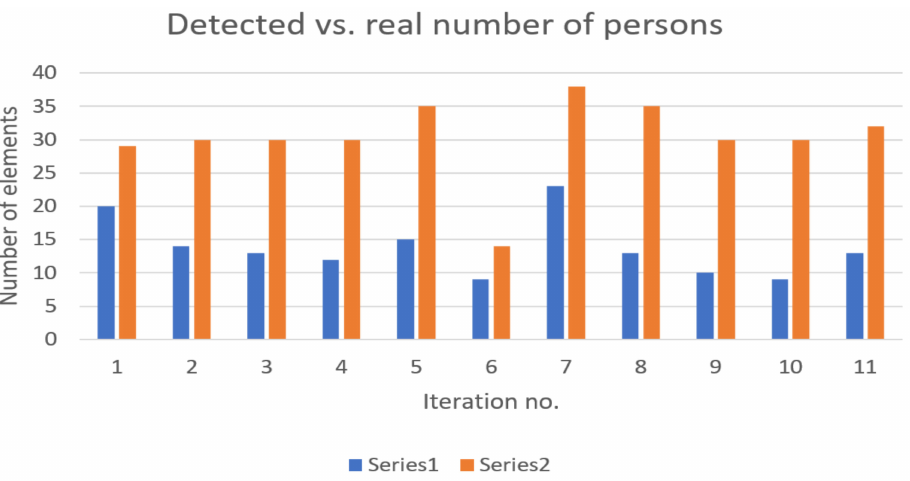
Figure 3. Detected devices (represented in blue—Series 1) versus real number of persons (represented in orange—Series 2) present on platforms—no trains in station (Subway Station